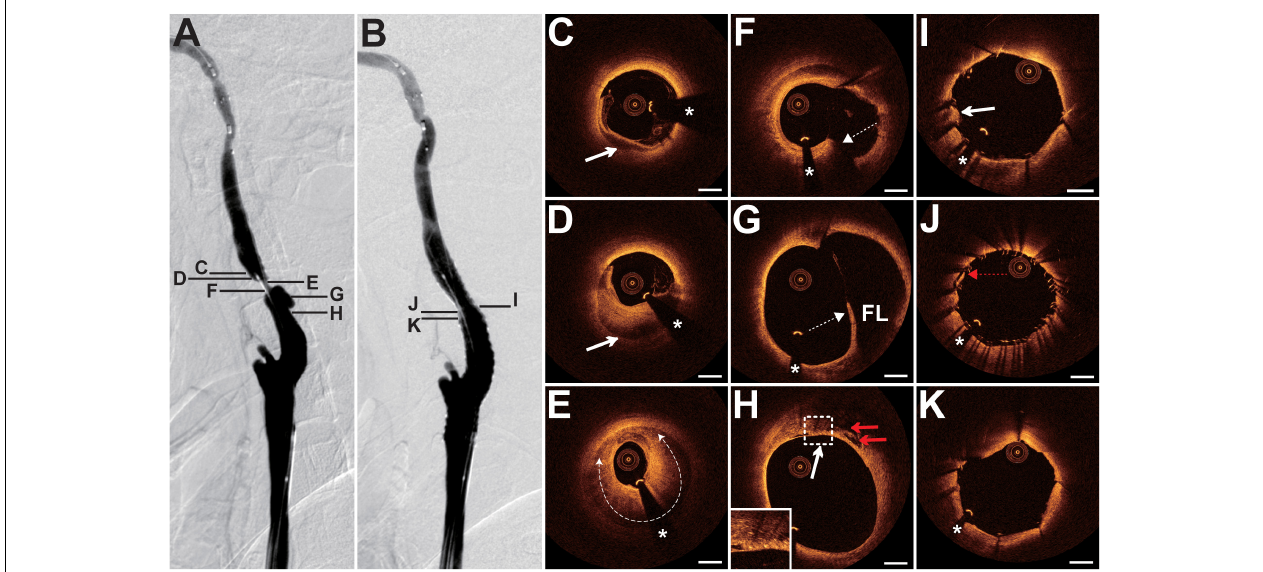
FIGURE 2 | DSA and OCT findings of the LICA lesion. Case 2. (A) The angiogram before stenting showed severe stenosis at the LICA C1 segment. (B) The angiogram after stenting. (C) The intramural hematoma (arrow) at 5–9 o’clock. (D) The intramural hematoma (arrow) occupied half of the vessel. (E) The intramural hematoma (dashed curve with arrows) expanded to nearly three-quarters of the vessel at the minimum lumen. (F) The intimal tear (dashed arrow) at 5 o’clock. (G) The double-lumen (the true lumen and the false lumen [FL]) and the floating intimomedial flap (dashed arrow) were identified. (H) The cavity formations (red arrows) and the macrophage accumulations (arrow). (I–K) Post-interventional OCT images. (I) The smooth tissue protrusion (arrow). (J) The residual small dissection (red dashed arrow). Image (J) corresponds to image (F) . Image (K) represents the image with the minimum lumen. Stent struts were well apposed. Scale bars represent 1 mm. Asterisks denote guide-wire artifact. DSA, digital subtraction angiography; LICA, left internal carotid artery; OCT, optical coherence tomography.